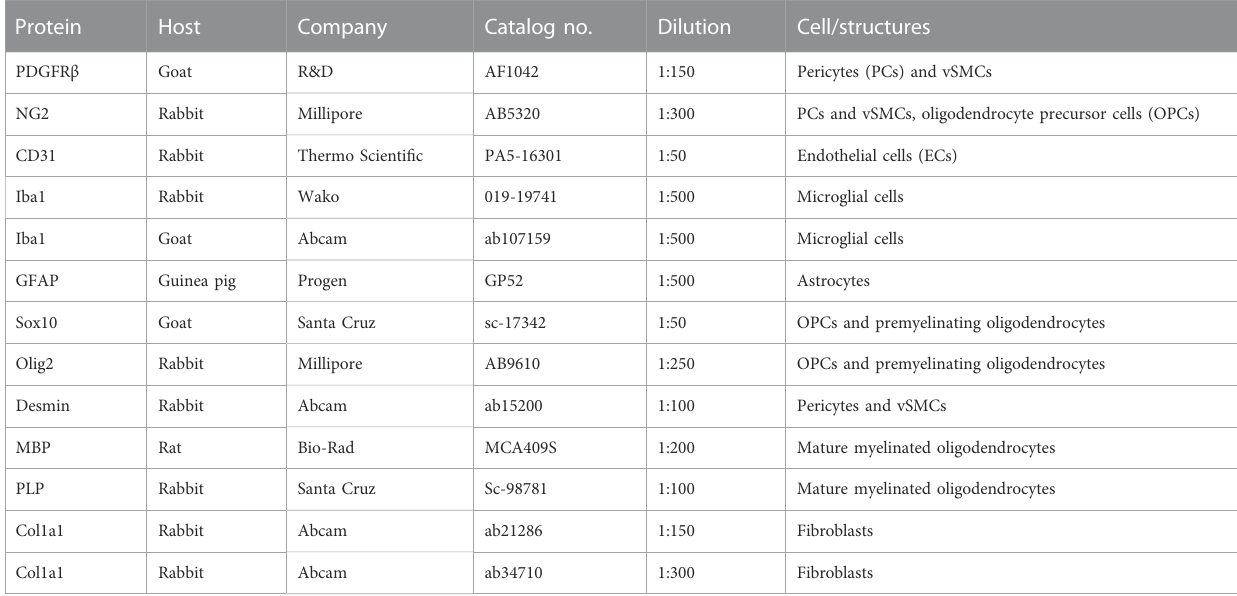
TABLE 1 Primary antibodies used in immuno fl